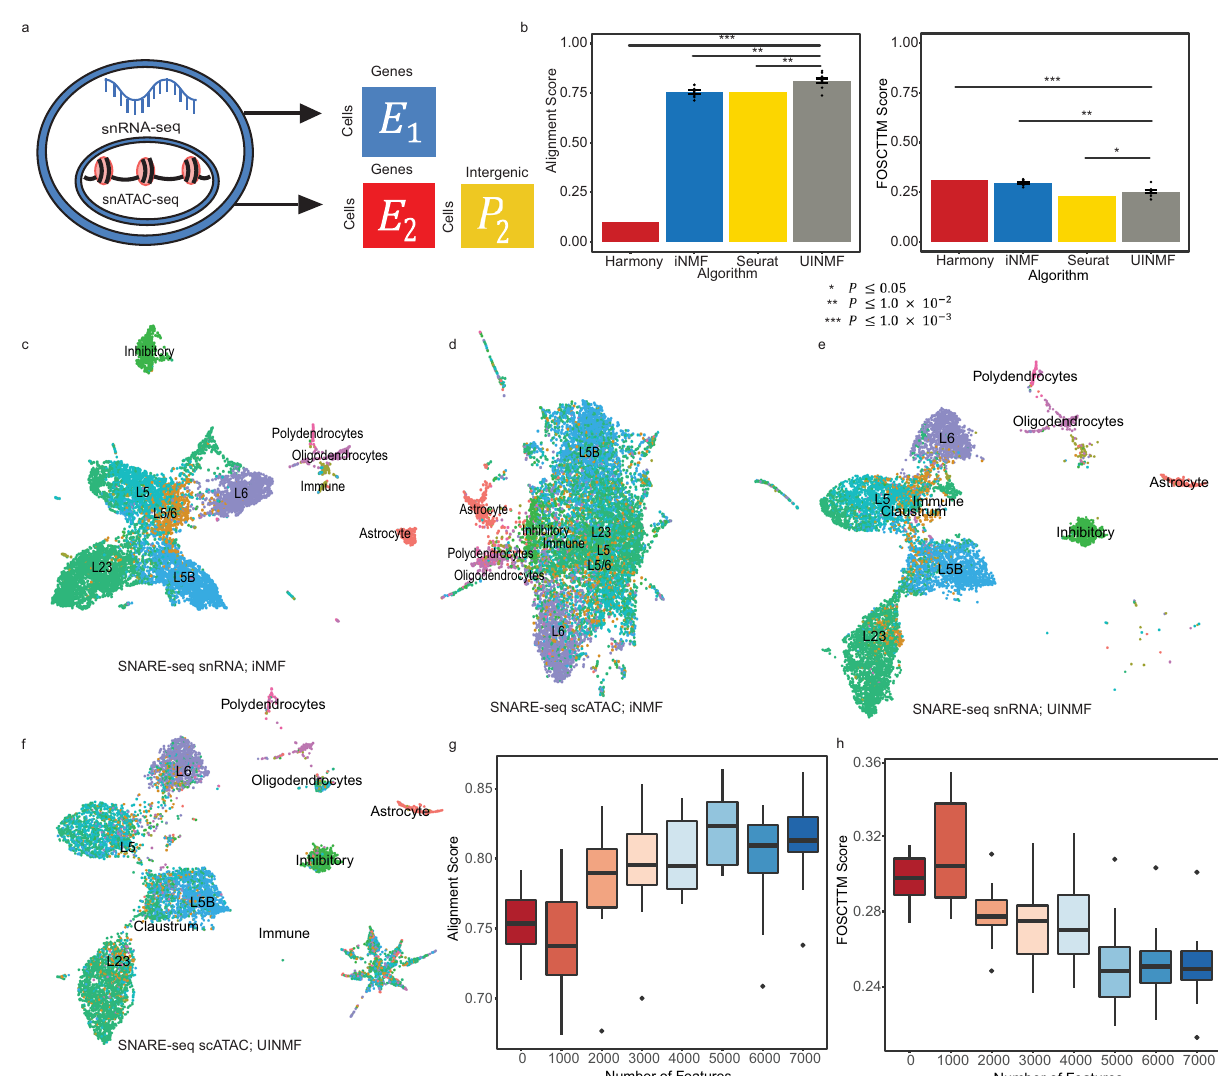
Fig. 2 Addition of intergenic peak information improves integration of RNA and ATAC datasets. a Schematic illustrating how the UINMF algorithm incorporates intergenic peaks when separately integrating the RNA and ATAC measurements from a SNARE-seq dataset. We treat each data type as if it came from an independent source, and perform an integration using regular iNMF and our proposed UINMF method, which incorporates intergenic peaks. b Average alignment and FOSCTTM (Fraction of Samples Closer Than True Match) scores for iNMF, Seurat v3, Harmony, and UINMF. iNMF and UINMF are both initialized 5 different times over ten random seeds, with UINMF including an additional 7,000 intergenic features into the analysis. For nondeterministic algorithms, data are presented as mean values + / − SEM. To compare algorithm performance, we used a paired, one-sided Wilcoxon test to compare UINMF ’ s alignment and FOSCTTM scores to iNMF ( P = 1.953 × 10 − 3 , P = 1.953 × 10 − 3 ), Seurat ( P = 1.953 × 10 − 3 , P = 0.01855), and Harmony ( P = 9.766 × 10 − 4 , P = 9.766 × 10 − 4 ), with Seurat exhibiting a signi fi cantly lower FOSCTTM score. For each algorithm, we compare 10 pairs of data points ( n = 20). We factorize and cluster the cells using their RNA transcripts ( c ) and chromatin accessibility measures ( d ) separately. After integration, we use the known cell correspondences to separately plot the gene expression ( e ) and chromatin accessibility datasets ( f ) from SNARE-seq, colored by the same cell type labels. We assess the contribution of information contained within the intergenic peaks by assessing the alignment ( g ) and FOSCTTM ( h ) scores across a range of included peaks, from 0 unshared features (iNMF) to 7000 unshared intergenic bins, adding 1000 unshared features to each analysis. The bold line indicates the median data value, and the boundaries of each box are de fi ned by the fi rst and third data quartiles (25 and 75%, respectively). The upper (lower) whiskers extend from to highest (lowest) point within 1.5 of the interquartile range. Outliers beyond the whiskers are plotted as points. We calculate FOSCTTM and alignment scores for ten random seeds for each number of unshared features ( n = aligned well across datasets (Fig. 2e, f), indicating that UINMF identi fi ed corresponding cell types even though the single-cell correspondence information was not used by the algorithm. In summary, including intergenic chromatin accessibility informa- tion in the integration of scRNA and snATAC data signi fi cantly improved the integration results.